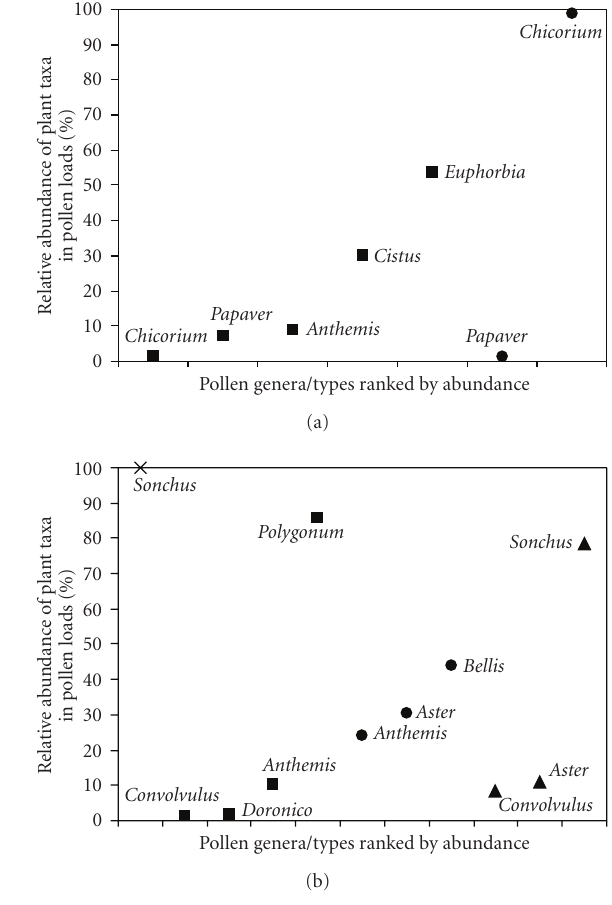
Figure 2: Relative abundance (%) of di ff erent pollen genera/types sampled in bee pollen loads through the period of collection. Marking symbols identify periods: × = April, (cid:2) = May, = June, (cid:3) = July / August. (a) Site A (wood site). (b) Site B (crop site). Only taxa with abundance > 1% were